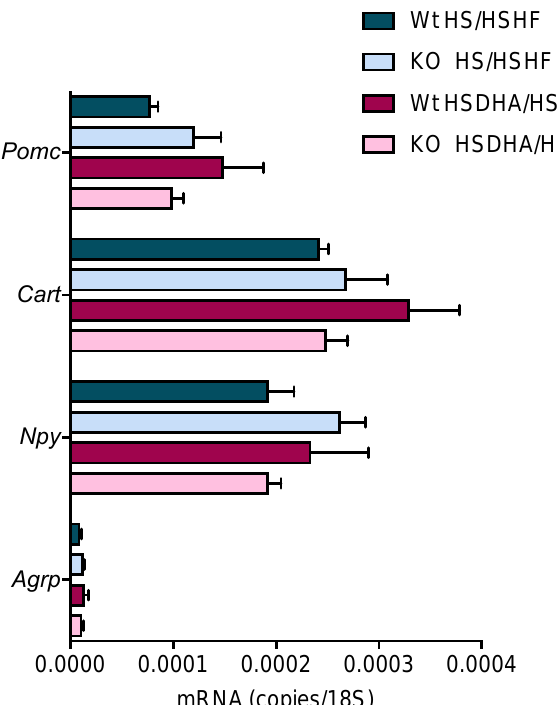
Figure 4. Hypothalamic mRNA expression of neuropeptides involved in the control of food intake is not affected by supplementation of DHA with high sucrose content. Relative hypothalamic gene expression of the orexigenic peptides NPY and AGRP and the anorexigenic peptides POMC and CART in wild-type and Elovl2 - / - mice fed high-sucrose (HS) or high-sucrose DHA-enriched diet (HSDHA) followed by high-sucrose, high-fat diet (HSHF) feeding. mRNA levels are shown relative to 18S expression. Results shown are means of four mice ± SEM.